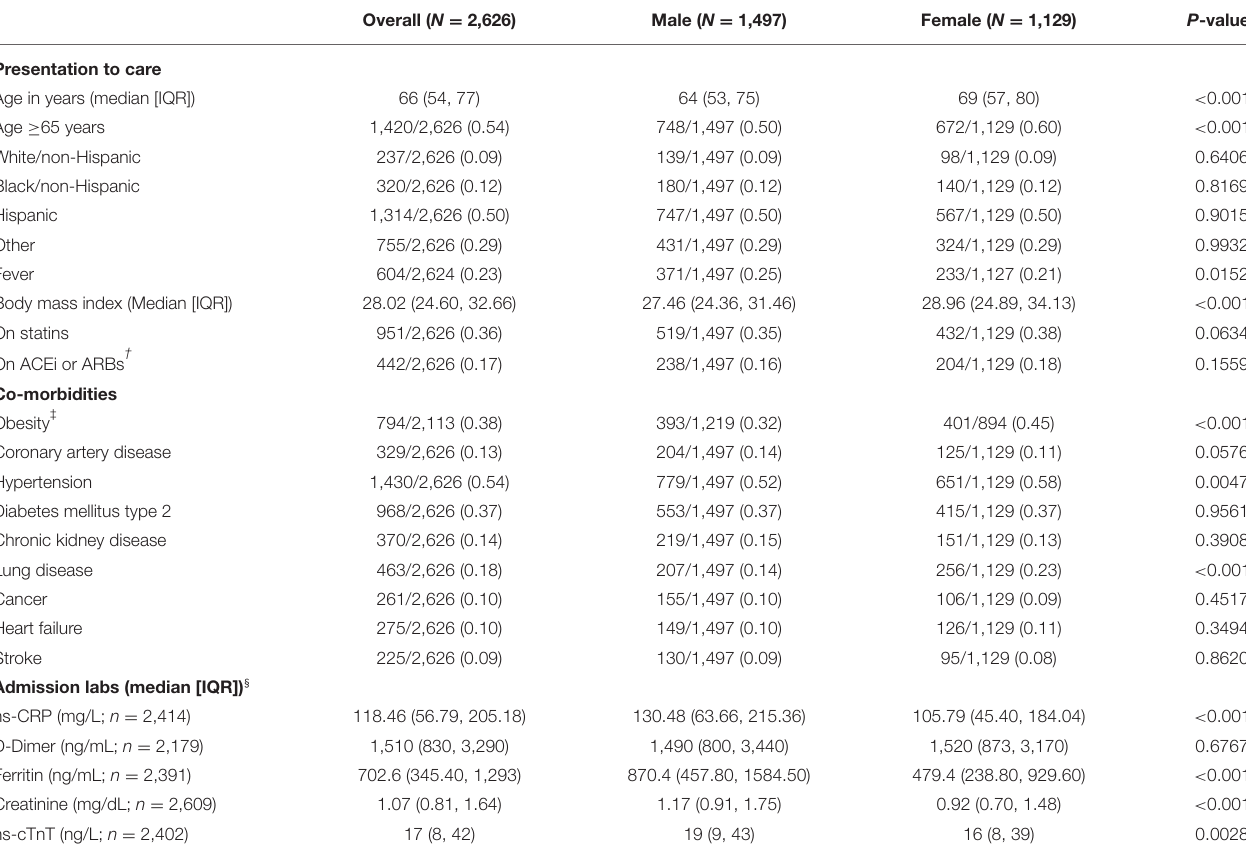
TABLE 1 | Clinical characteristics and admission labs overall and by sex in the CUIMC/NYP COVID-19 cohort.